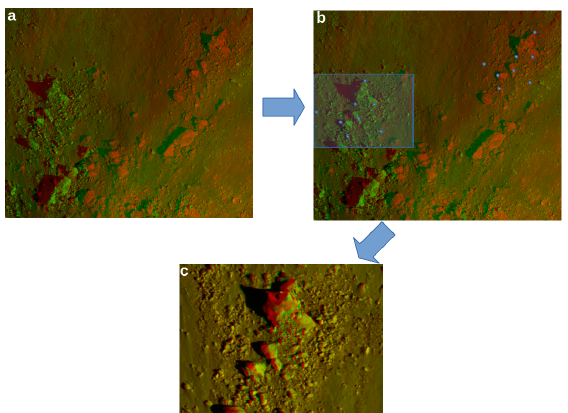
Figure 3: An example of the application of the pre-processing on LRO images. (a) overlay of input images, (b) grid region (blue rectangle) and detected features (blue points) visualized on the images, (c) overlay of the grids after the transformation At the core of the matcher, AB matching techniques like normal- ized cross-correlation (NCC) and least-squares matching (LSM) are used to perform a dense matching. Here it is attempted to find a match for every pixel of the template image. Equation 1 shows the well known formula to compute the cross-correlation coefficient ( ρ ncc ) between two patches ( a and b